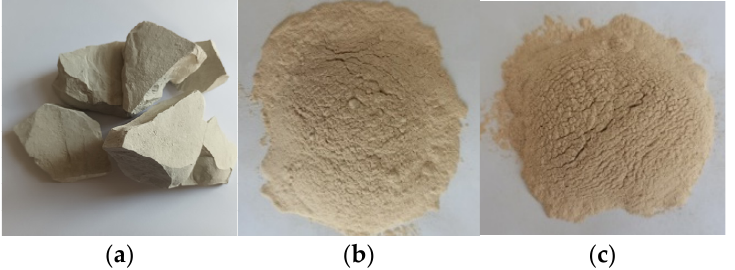
Figure 1. Zeolitic volcanic tuffs from Chilioara quarry before ( a ) and after micronization CS100 ( b ) and CS40 ( c ).